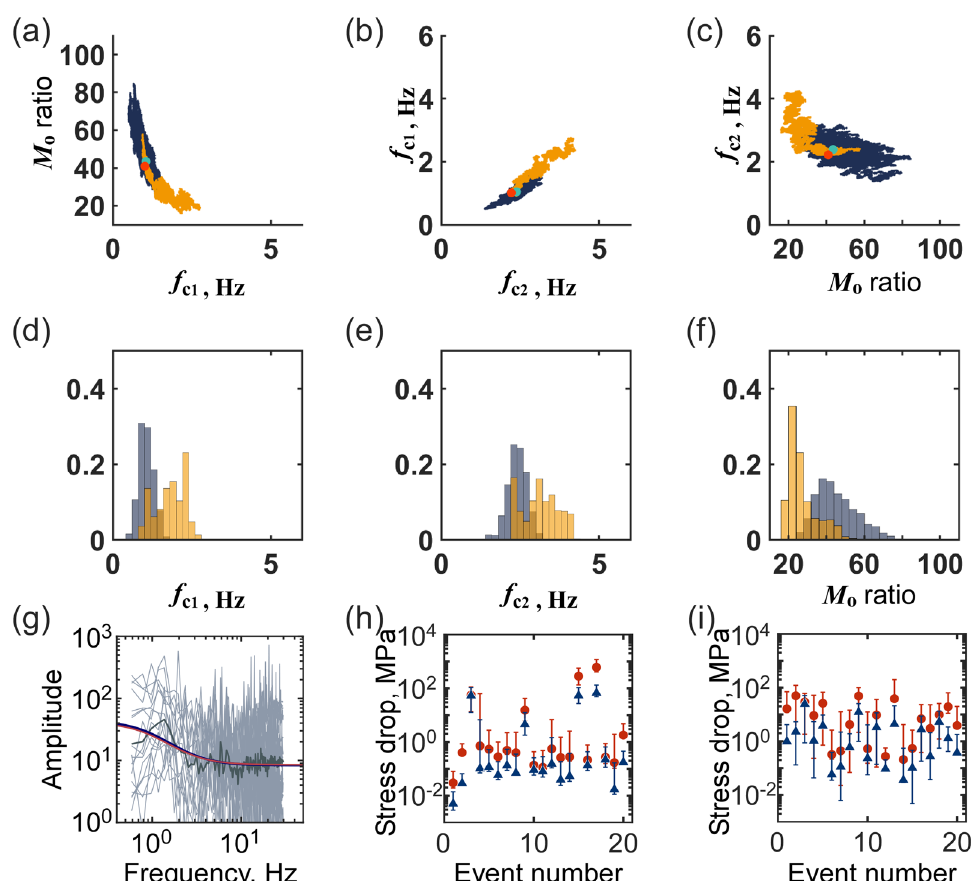
Fig. 4 Seismic parameters estimated from observational data subjected to 200,000 iterations of MCMC analysis. a Sampling distribution projected onto a 2D plane. Relationship between moment ratio and f c 1 , b f c 1 and f c 2 , and c moment ratio and f c 2 . Dark blue areas indicate results assuming an F -distribution, and yellow areas indicate results assuming a normal distribution. Cyan and orange dots indicate the best point of the calculation, respectively. d Histogram of the sampling in f c 1 , e f c 2 , and f moment ratio. g Spectral ratios of the 7th event in Table 1. Gray, black, and red curves, respectively, indicate spectral ratio for each seismic station, average of all spectral ratios, and the theoretical spectral ratio based on the maximum likelihood value. h Estimated stress drops for 20 events from a cluster assuming an F -distribution. Red circles indicate the results obtained from large earthquakes, and blue triangles indicate results obtained from small earthquakes. The thin bars indicate 95% confidence interval obtained from the variation of the accepted sampling. i Estimated stress drops for 20 events from a cluster assuming a normal distribution. Red circles indicate results obtained from large earthquakes, and blue triangles indicate results obtained from small